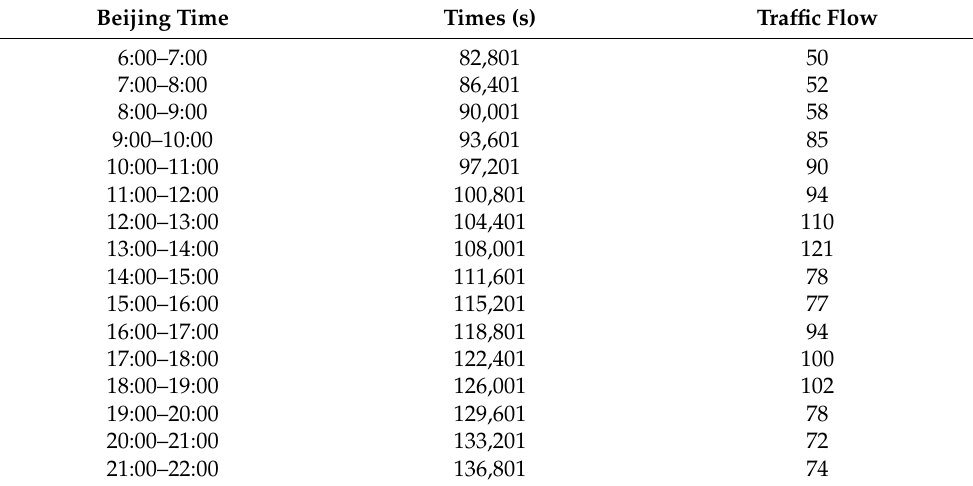
Table 2. Traffic flow on Ansi Road on 31 January 2021.